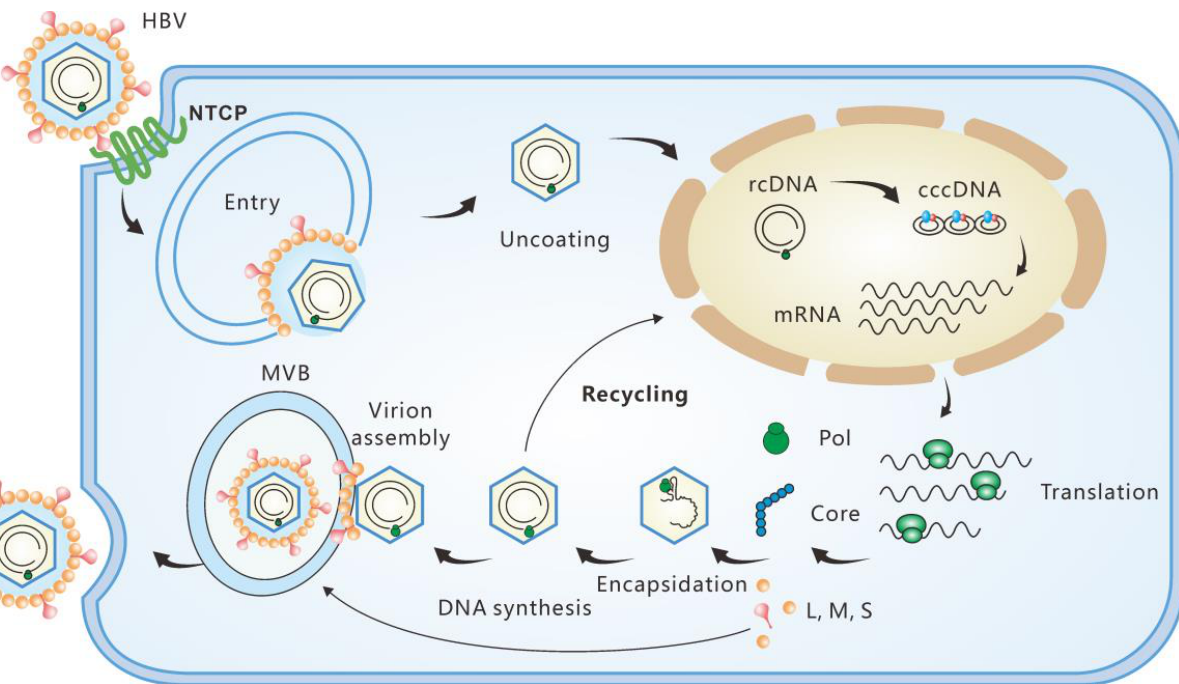
Figure 1. Replication cycle of HBV. The viruses infect hepatocytes by interacting with the receptor sodium taurocholate cotransporting polypeptide (NTCP). Relaxed circular DNA (rcDNA) is released into the nuclei after nucleocapsid uncoating. With the help of the host factors, rcDNA is converted into cccDNA, which serves as the template of viral RNA transcription. The productive nucleocapsid containing progeny rcDNA either secretes through the multivesicular body (MVB) pathway or recycles to the nuclei.